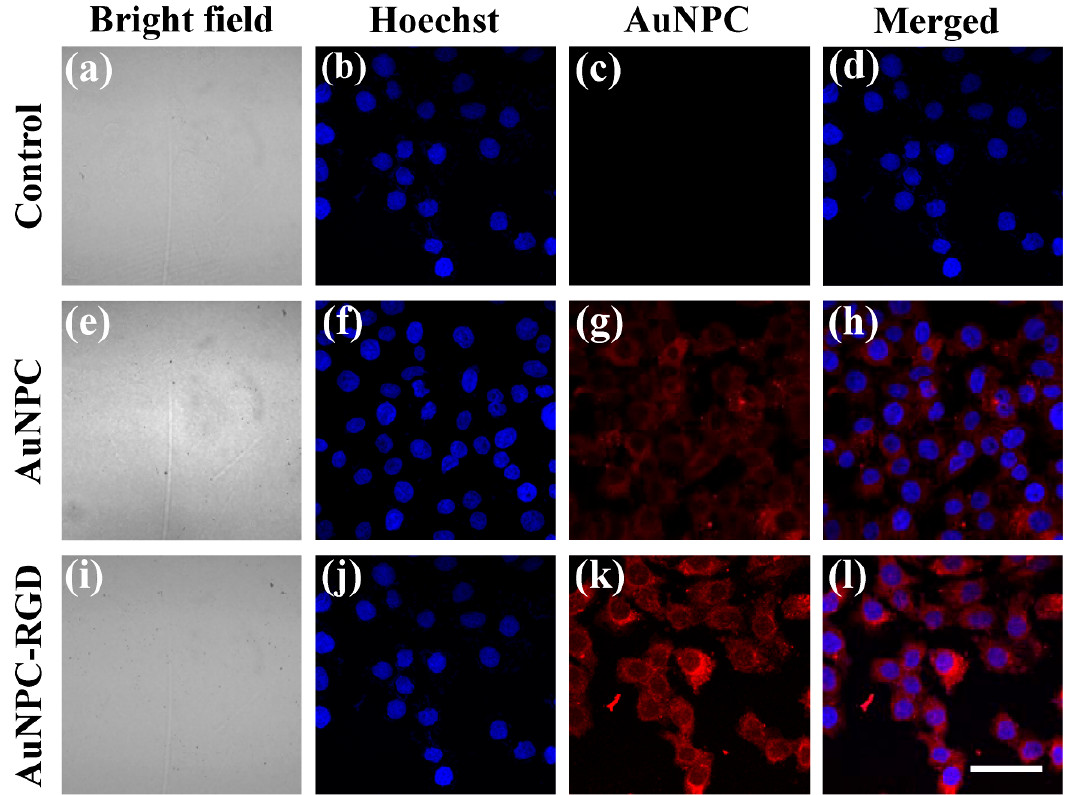
Figure 5. Laser confocal microscopy images of HeLa cells incubated with/without nanoparticles. ( a – d ) Without nanoparticles; ( e – h ) with AuNPC; ( i – l ) with AuNPC-RGD ( i – l ). Hoechst and AuNPC were excited at the same wavelength of 405 nm, and the fluorescence images were taken at 420–480 and 600–660 nm, respectively. Scale bar: 50 µm.